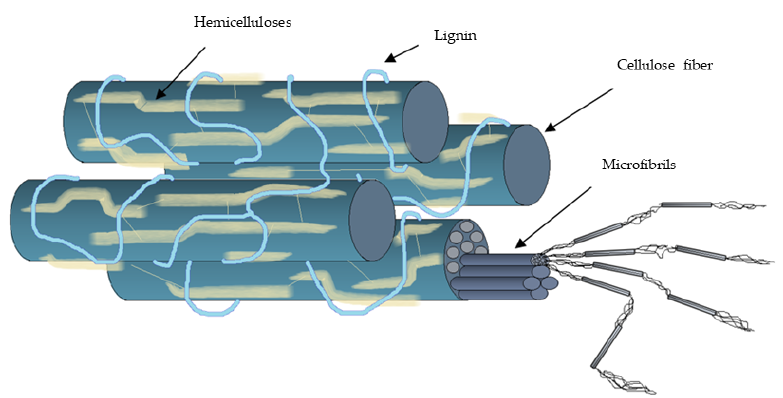
Figure 3. General structure of lignocellulose.